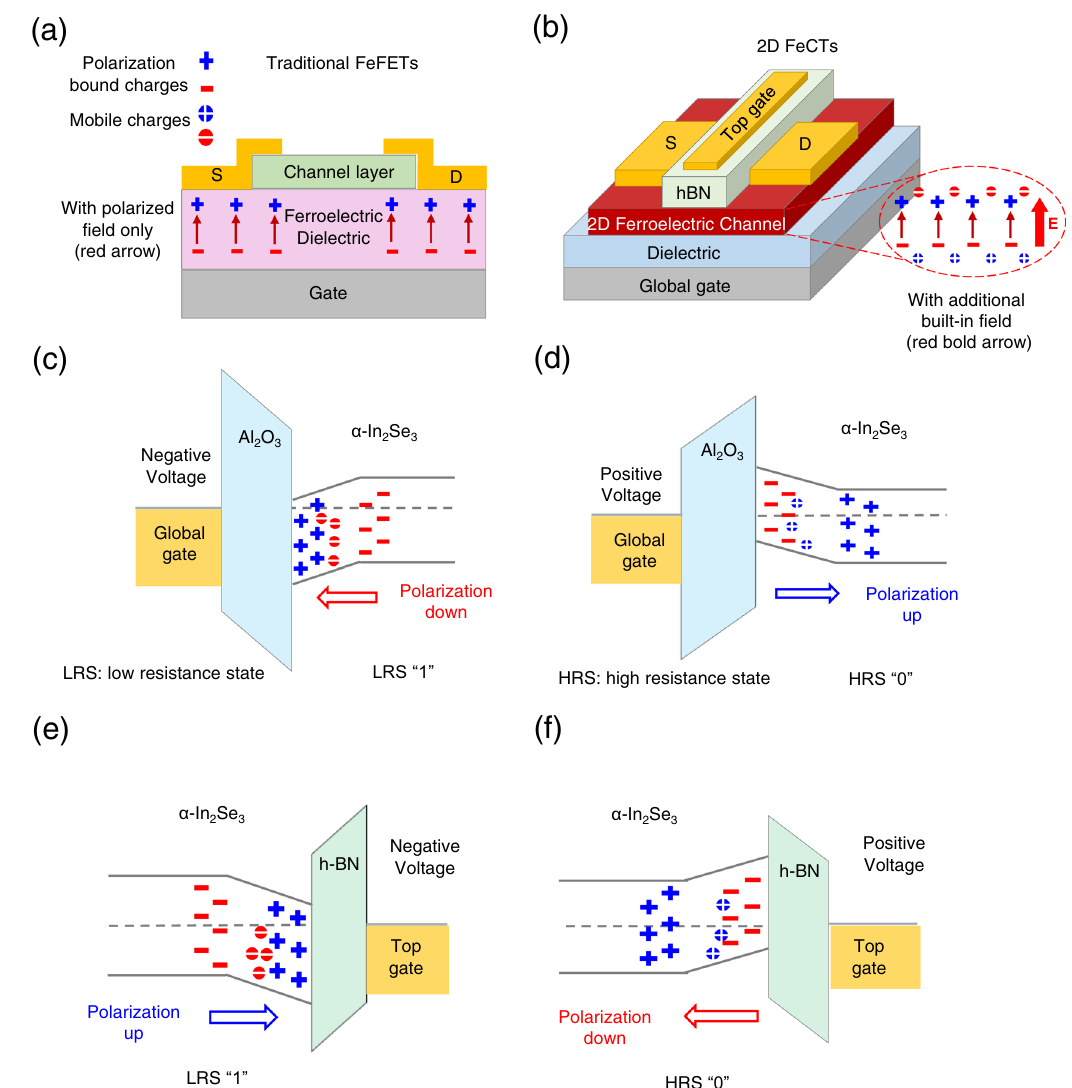
Fig. 2 Comparison of FeFETs and FeCTs structure and working mechanism. a For FeFETs, traditional ferroelectrics act as the dielectric layer, where only polarization-bound charges exist, and channel conductance is modulated by polarization switching. b The ferroelectric semiconductor 2D α -In 2 Se 3 in FECTs serves as the channel layer and has both polarized bound charges and mobile charges. When in a polarized upward state, positive and negative polarized bound charges are distributed on the top and bottom surfaces of the channel, respectively, which causes positive and negative mobile charges to accumulate in opposite positions, forming an upward built-in electric fi eld to maintain upward polarization. c For GG, a negative voltage lower than the coercive voltage is applied, and the bottom channel distributes positive polarized bound charges, the energy band is bent downward, and electrons are accumulated to form LRS, which corresponds to downward polarization. d When GG applies a positive voltage higher than the coercive voltage, the negative polarized bound charges are distributed at the bottom of the channel, and the energy band bends upward. The depletion of electrons results in HRS, which corresponds to the upward polarization. e Similarly, for TG, a negative voltage is applied, the top channel distributes positive polarized charges, and electrons accumulate to form LRS, which corresponds to polarization up. f A positive voltage applied in TG, the top channel distributes negative polarized bound charges, and electrons are depleted to form HRS, corresponding to polarization down. It should be noted that owing to the high EOT of FeCTs gate dielectric and the insuf fi cient electric fi eld along the channel, incomplete polarization switching and localized mobile charges distribution are